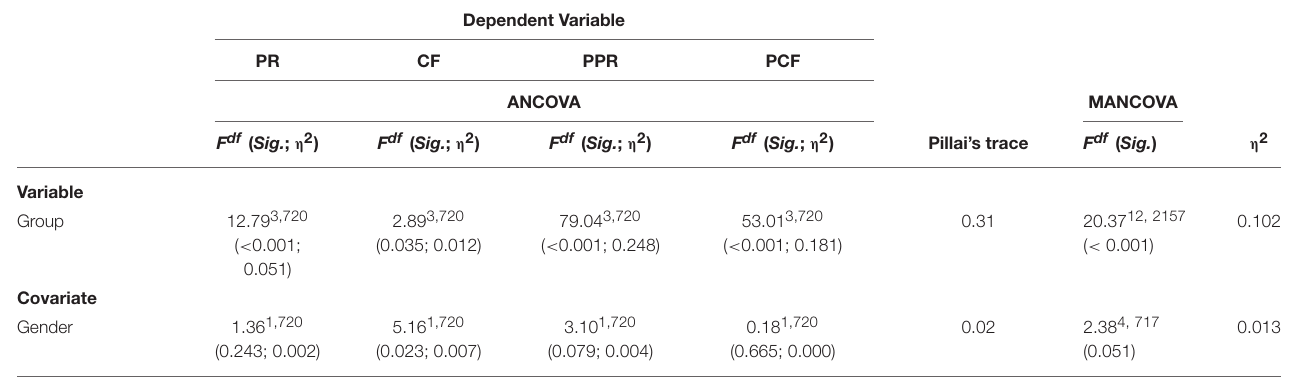
TABLE 4 | The effects of group (latent profile) on probabilistic reasoning task performance.